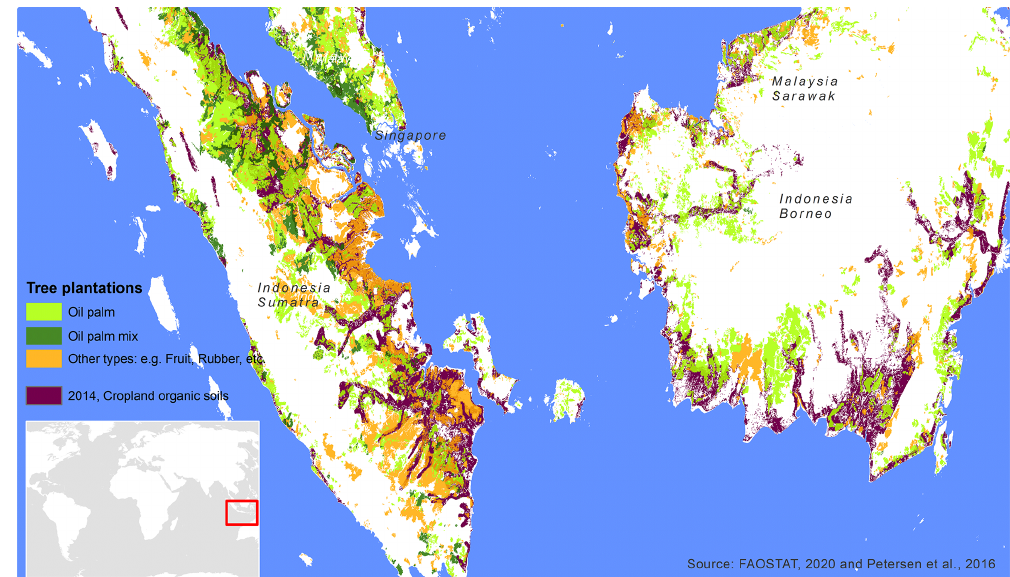
Figure 14. Oil palm and other tree plantations (Petersen et al., 2016) and FAOSTAT cropland organic soils in 2014.